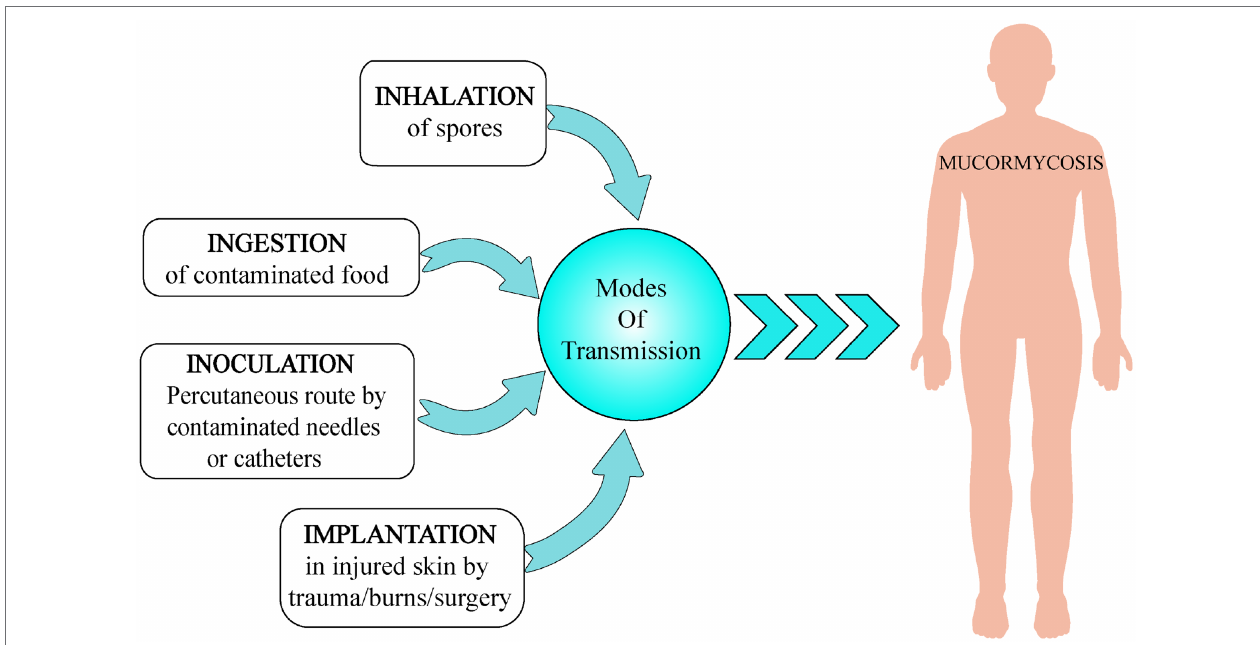
FIGURE 3 | Various modes of transmission of mucormycosis include (a) inhalation, (b) ingestion, (c) inoculation, and (d)